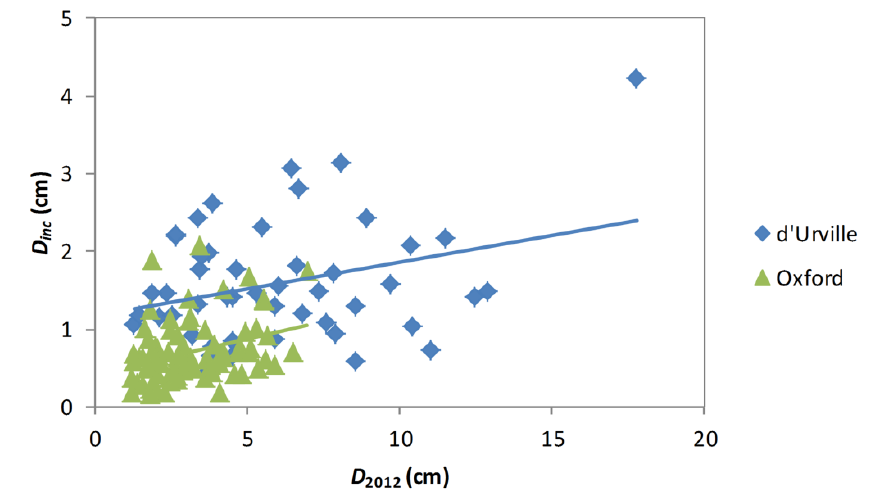
Figure 3. Relationships between D linear regressions for each site.